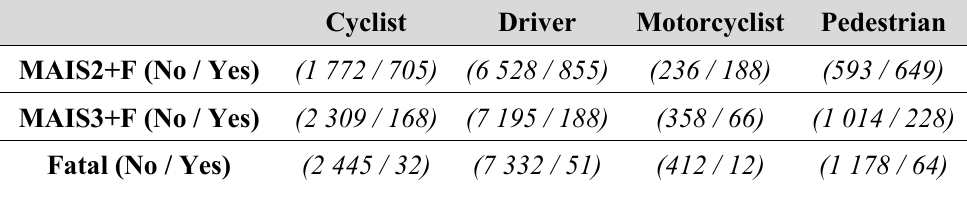
Table 1. Data sample distribution over road users and injury